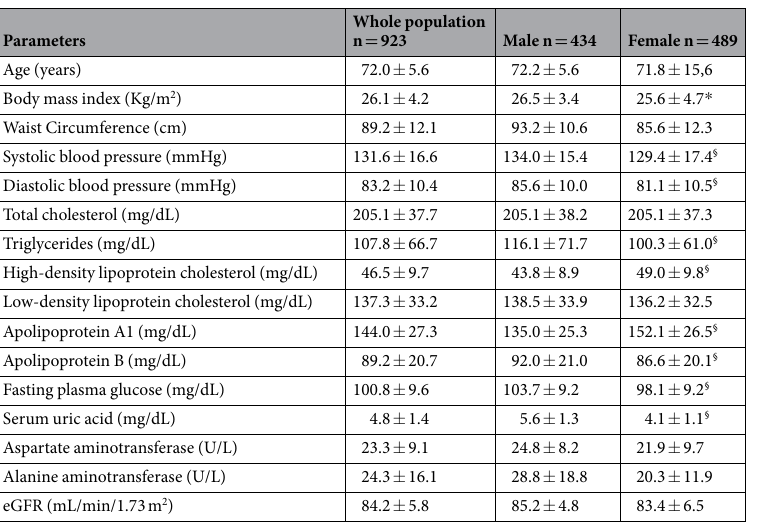
Table 1. Main characteristics of the sample (2008), overall and sex-distributed, expressed as mean ± standard deviation. eGFR, estimated glomerular filtration rate. * P = 0.001 vs men; § P < 0.001 vs